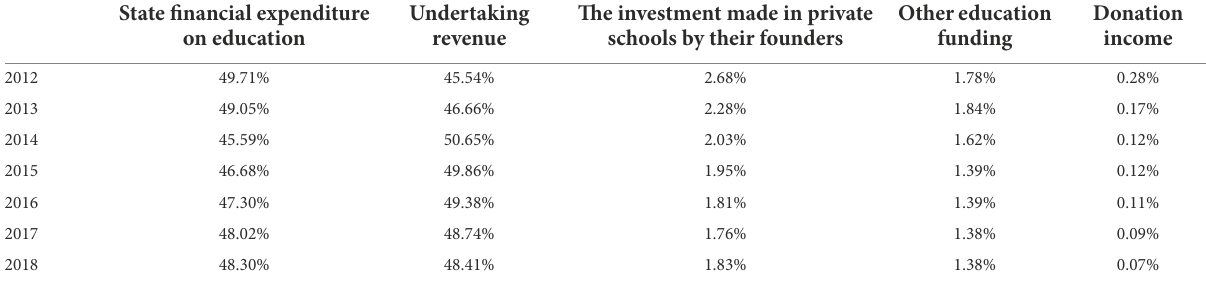
TABLE 2 Proportion of different sources of kindergarten education